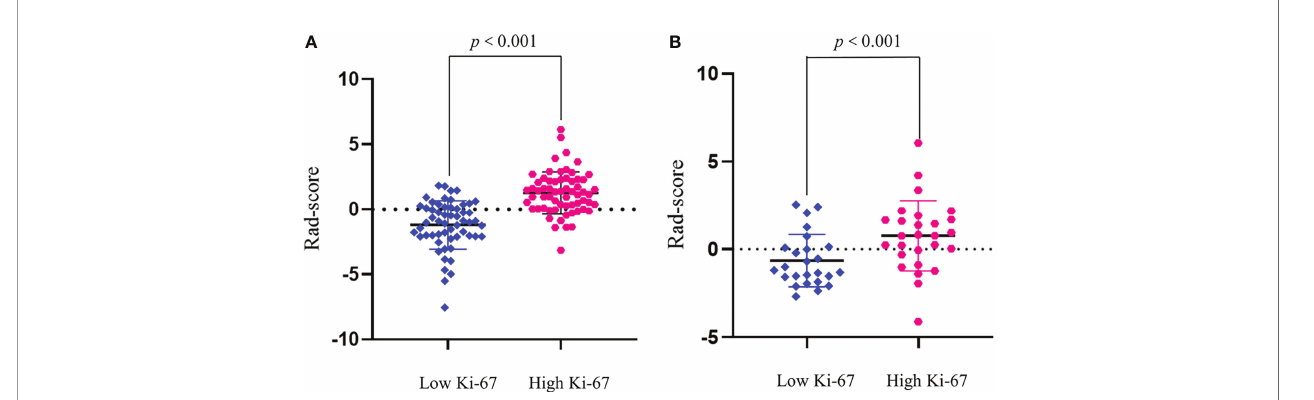
FIGURE 4 | Rad-score between high and low Ki-67 expression groups in the training (A) and validation (B) groups. Rad-score of the high Ki-67 expression group (red) was signi fi cantly higher than that of the low Ki-67 expression group (blue).